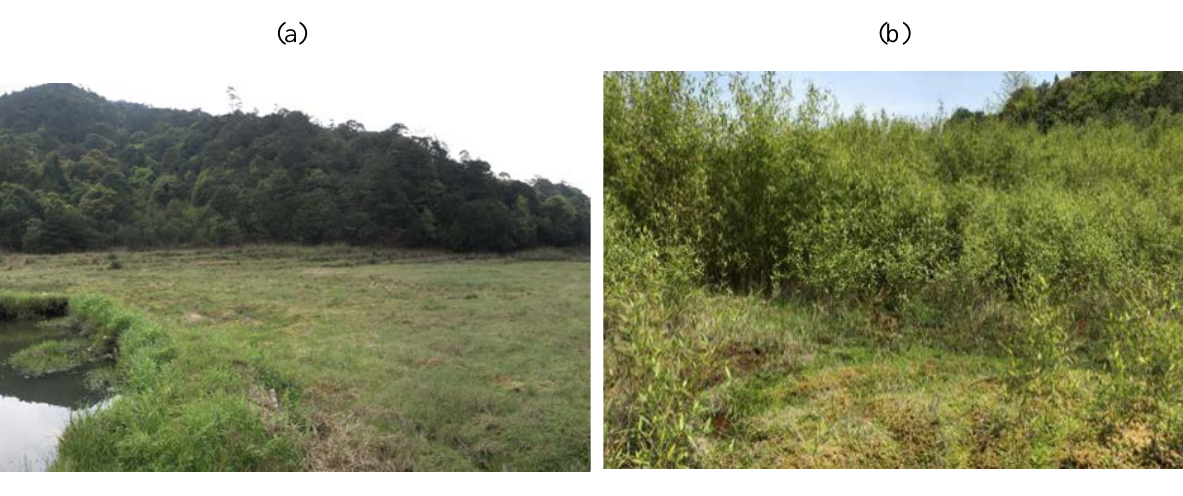
Figure 3. (a) View of the study site, which is a Sphagnum bog in TNNR. (b) P. heteroclada and S. magellanicum plant community on the study site (from Pang et al .